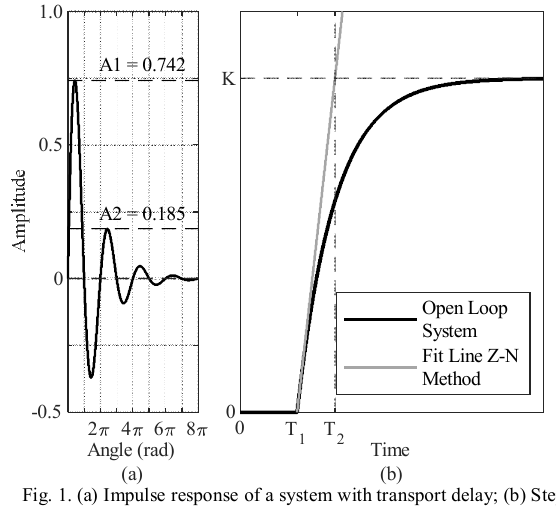
Fig. 1. (a) Impulse response of a system with transport delay; (b) Step response